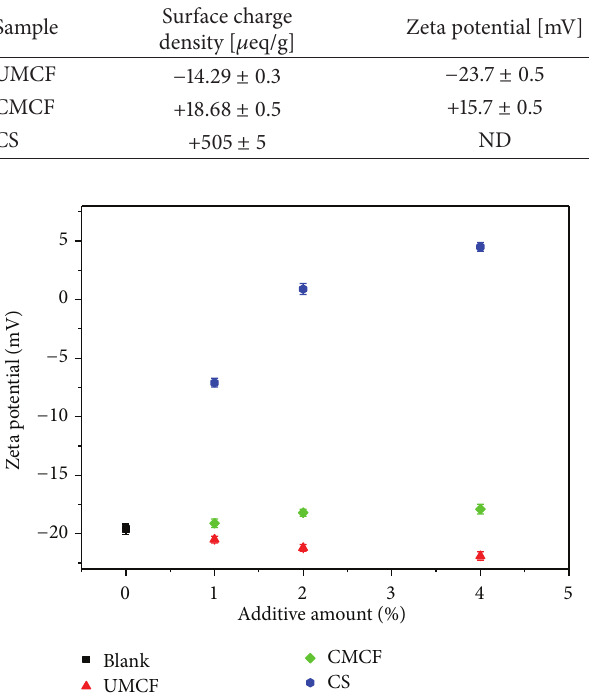
the obtained nitrogen content of CMCF was 1.16%; according to formula (1), the degree of substitution (DS) was calculated